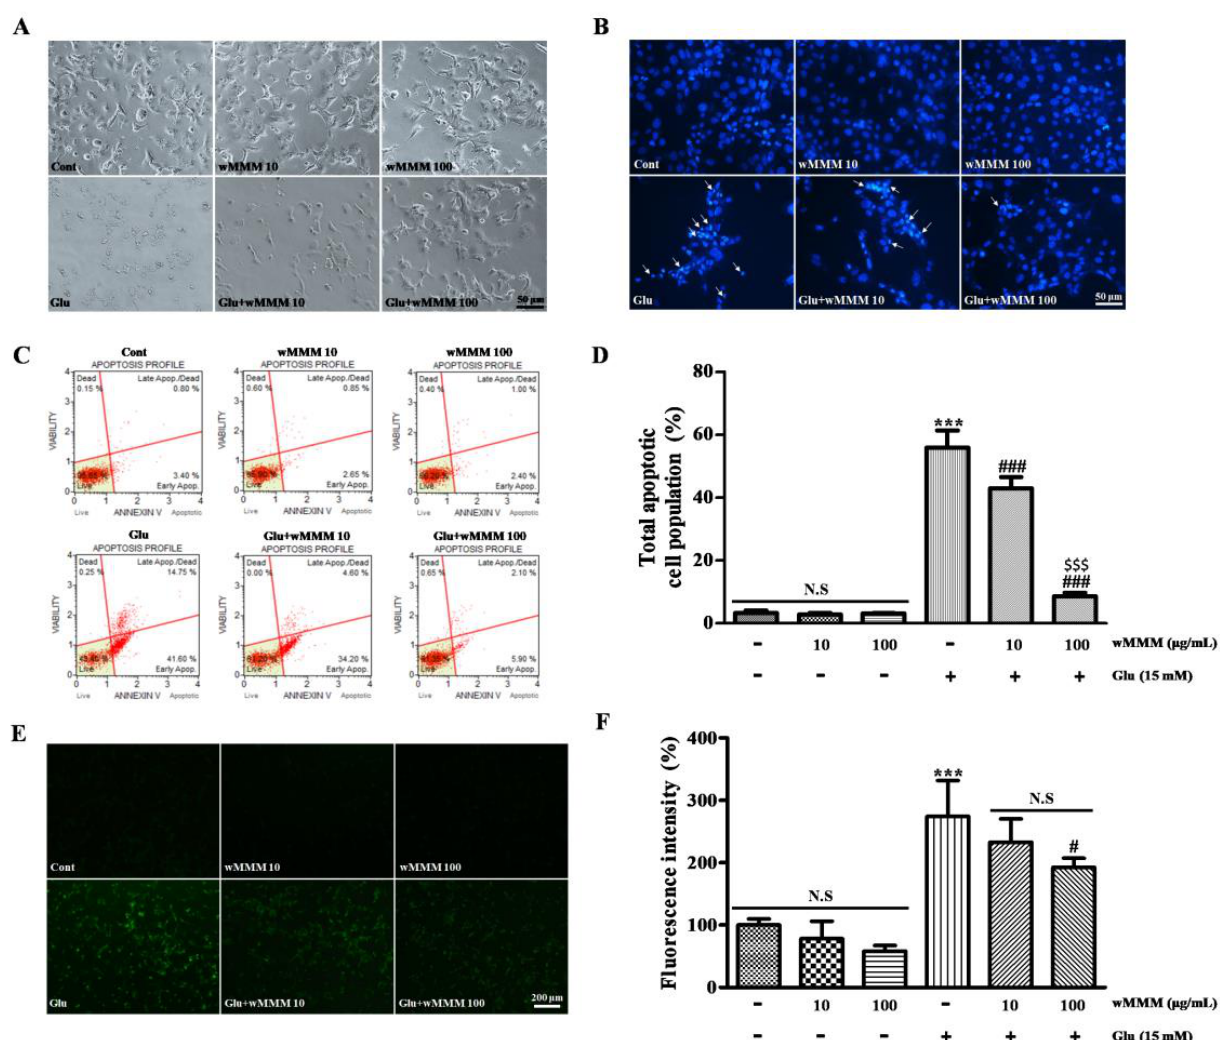
Figure 3. Anti-apoptotic and anti-oxidative effects of water extracts of mixed mushroom mycelia (wMMM) on PC-12 cells challenged with glutamate-induced excitotoxicity. Representative cell morphologies ( A ) and Hoechst 33258-stained nuclei ( B ) captured by inverted microscopy. Shrunken and illuminating nuclei depicted with white arrows. Representative dot plot ( C ) obtained by Annexin V-FITC/7-AAD-based flow cytometry and bar graphs ( D ) quantifying the ratio of apoptotic cells (early and late apoptotic/dead cells) per total cells are shown. Representative 2 (cid:48) , 7 (cid:48) -dichlorodihydrofluorescin diacetate (DCF-DA)-stained fluorescence images ( E ) and the bar graphs quantifying the fluorescence intensities ( F ). For ( A – D ), the co-treatment was accomplished by 16 h of pre-incubation with MMM extracts (10 or 100 µ g/mL) and an additional 24 h of incubation with glutamate (15 mM). For ( E , F ), the co-treatment was carried out by 16 h of pre-incubation with MMM extracts (10 or 100 µ g/mL) and an additional 10 min of incubation with glutamate (15 mM). In both graphs ( D , F ), data are represented as the mean ± standard deviation (*** p < 0.001 vs. cells without wMMM and glutamate; # p < 0.05 and ### p < 0.001 vs. cells treated with glutamate only; $$$ p < 0.001 vs. cells co-treated with 10 µ g/mL wMMM and glutamate; N.S, not significant). In all graphs, significance was determined by one-way ANOVA followed by a Tukey post hoc test for pairwise comparisons. The experiments and data acquisitions were carried out in